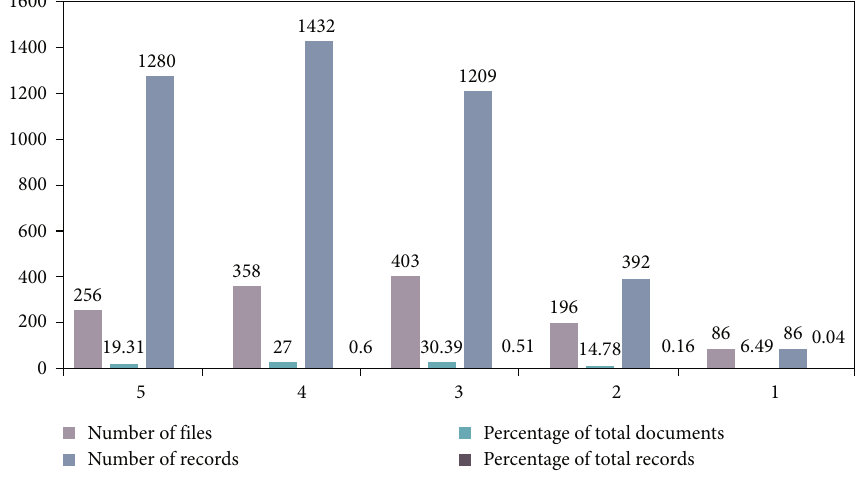
Figure 3: Number of records containing anomalous data versus number of fi les and number of